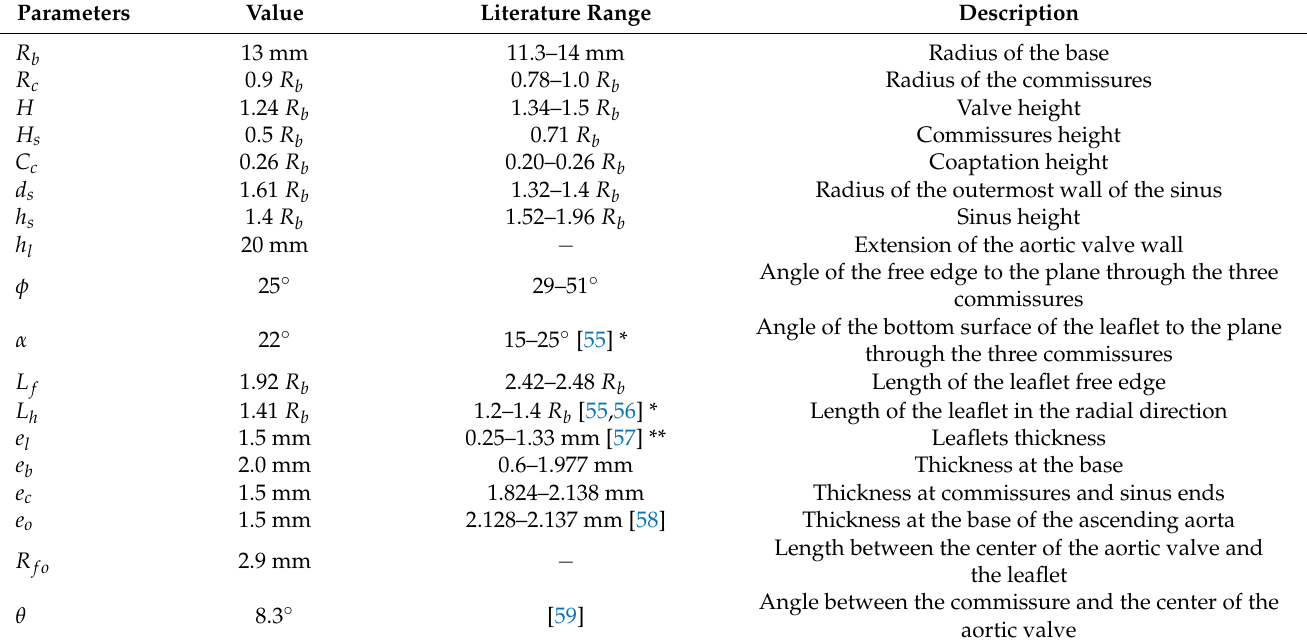
Table 1. Dimensions of the aortic valve